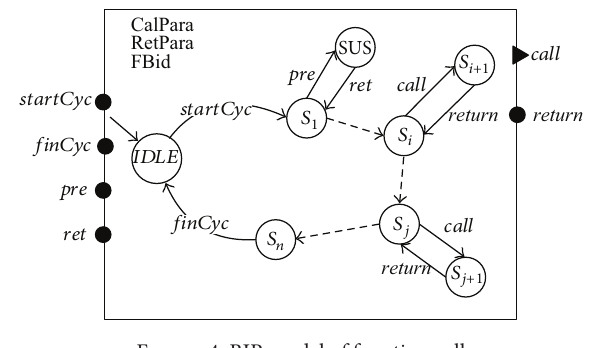
Figure 4: BIP model of function call.